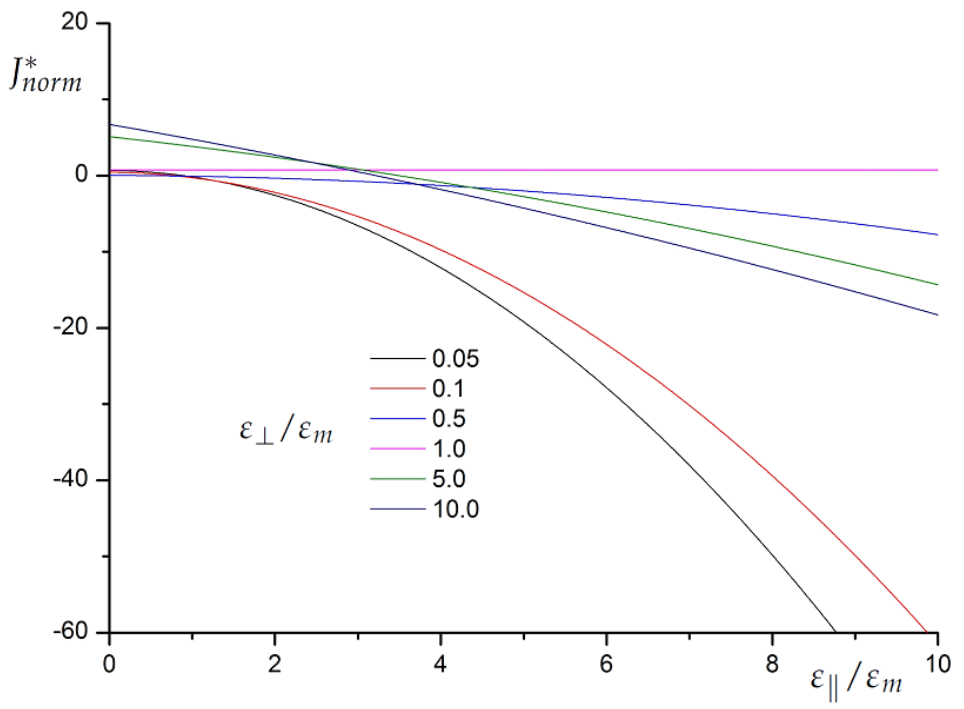
Figure 1. The dependence of the coupling constant on ε (cid:107) / ε m and ε ⊥ / ε m